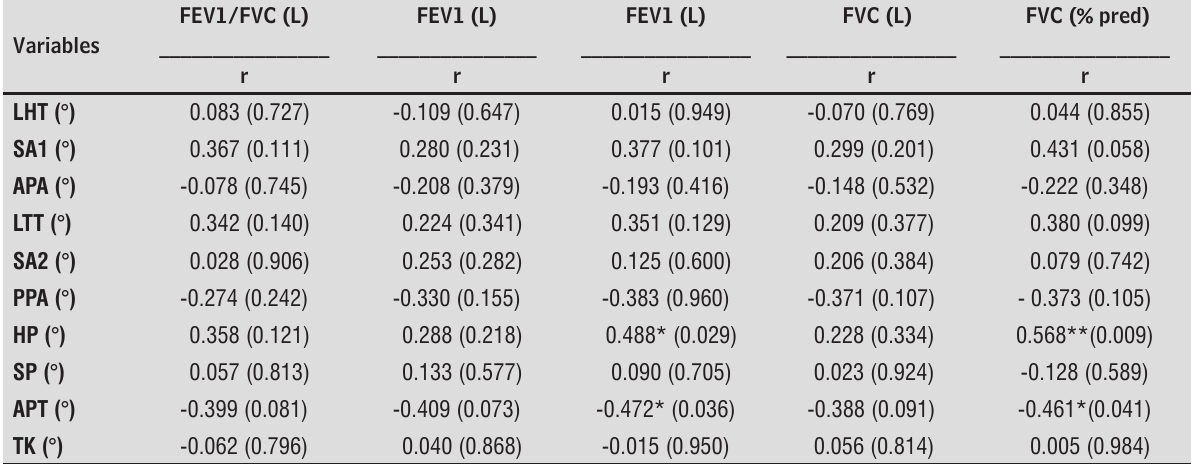
Table 4 - Correlation between pulmonary function and measures of postural alignment of COPD group (n = 20)